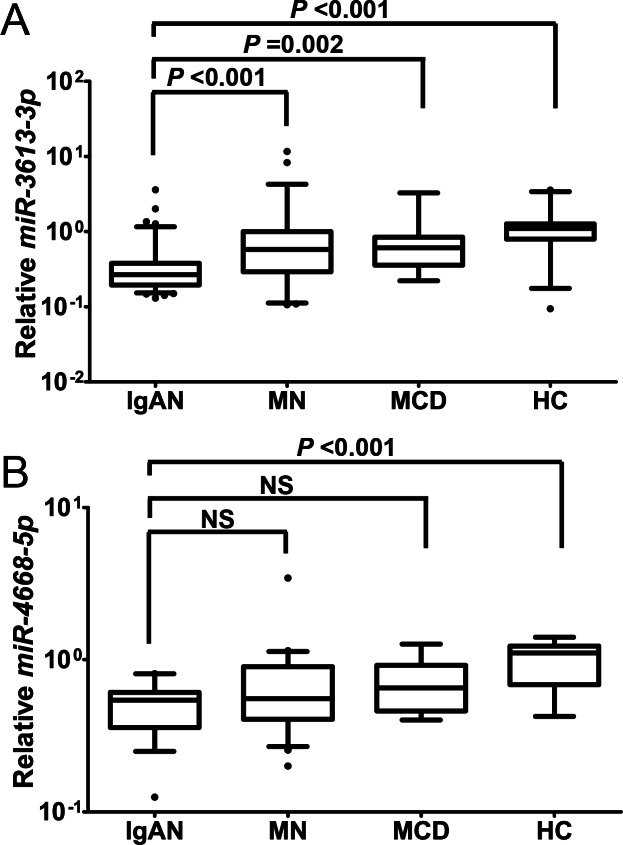
Comparison of candidate miRNAs levels between IgAN and each control group.Urinary levels of candidate miRNAs were analyzed by RT-qPCR in the validation cohort, which including 102 patients with IgAN, 41 patients with MN, 27 patients with MCD and 34 healthy controls. The whisker-box plots depict the relative expression level of miR-3613-3p and miR-4668-5p. The boxes indicate median and 25th and 75th percentiles; whisker caps indicate 5th and 95th percentiles. Statistically significant differences were determined by Mann–Whitney U test. Levels are represented as ratio to the median of healthy controls. NS, not significant (P > 0.05); IgAN, IgA nephropathy; HC, healthy control; MN, membranous nephropathy; MCD, minimal change disease. (A) Urinary miR-3613-3p levels was significantly lower in IgAN as compared with that in HC, MN and MCD, respectively [0.27 (0.19–0.38), n = 102 vs. 1.10 (0.9–1.26), n = 34; 0.58 (0.32–1.00), n = 41 and 0.61 (0.39–0.77), n = 27; respectively, all P < 0.01]. (B) Urinary miR-4668-5p levels were significantly lower in IgAN than that in HC [0.54 (0.38–0.60), n = 102 vs. 1.11 (0.73–1.22), n = 34; P = 0.001]. Urinary miR-4668-5p levels there were were not different between IgAN and MN and MCD [0.54 (0.38–0.60), n = 102 vs. 0.56 (0.41–0.88), n = 41 and 0.65 (0.49–0.87), n = 27; repectively].